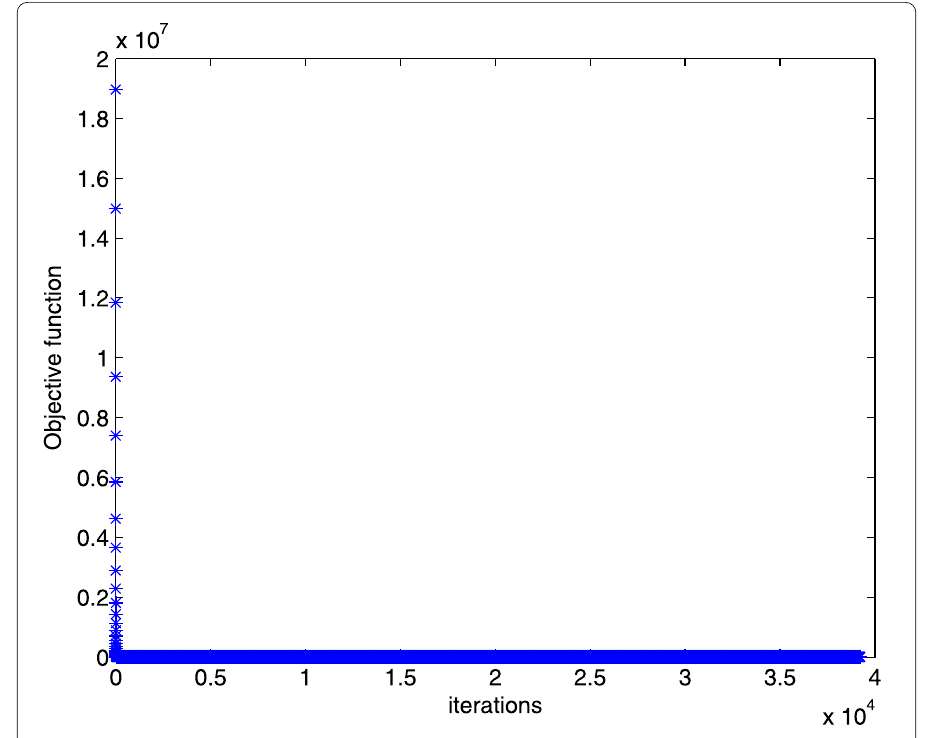
Figure 5 Numerical results for solving Example 3 with Algorithm 1